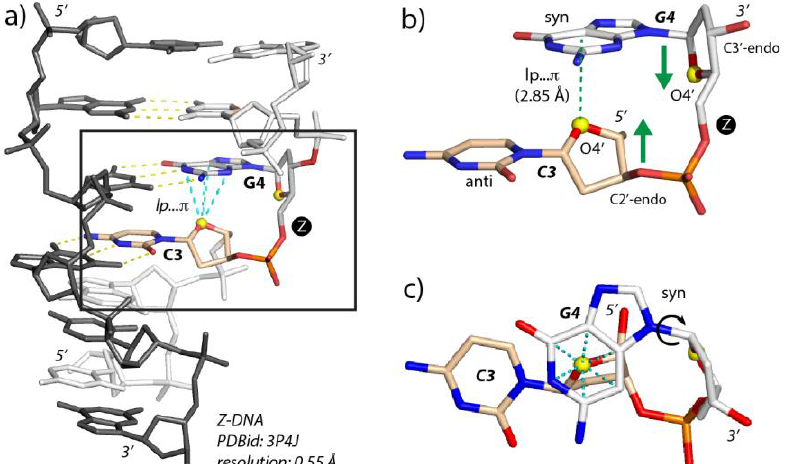
Figure 3. A representative Z-DNA CpG step and associated lp…π contact . ( a ) View of a 0.55 Å X-ray structure of a d (CpGpCpGpCpG) 2 duplex [32]. A representative CpG segment is boxed and colored as in ( b ); the remaining nucleotides of this strand are in white. The second strand is in dark grey. The lp…π contacts and the base pair hydrogen bonds associated with the CpG segment are marked by cyan and yellow dashed lines, respectively. This structure contains six lp…π contacts, one for each CpG step. ( b ) Close-up of the CpG motif boxed in ( a ). The O 4′ atoms are yellow; the cytosine (C) and guanine (G) carbons are wheat and white, respectively. The O 4′ atom of C3 stacks with the 3′ face of G4. Note the characteristic Z-DNA alternation of anti and syn conformations [12]. The head-to-head orientation of the two sugar rings, common for Z-steps, is marked by green arrows. ( c ) Orthogonal view of b). In ( a , b ), the “Z” letter (circled with a black background) marks the occurrence of a